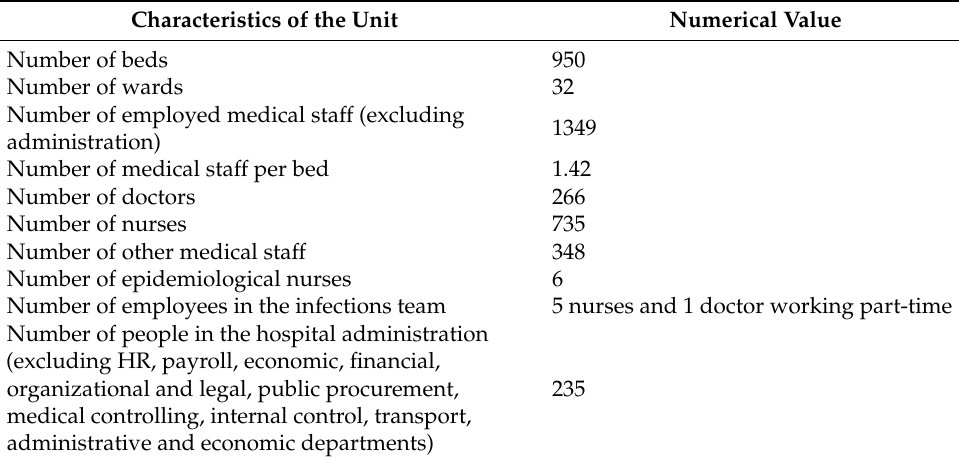
Table 5. Characteristics of the hospital under